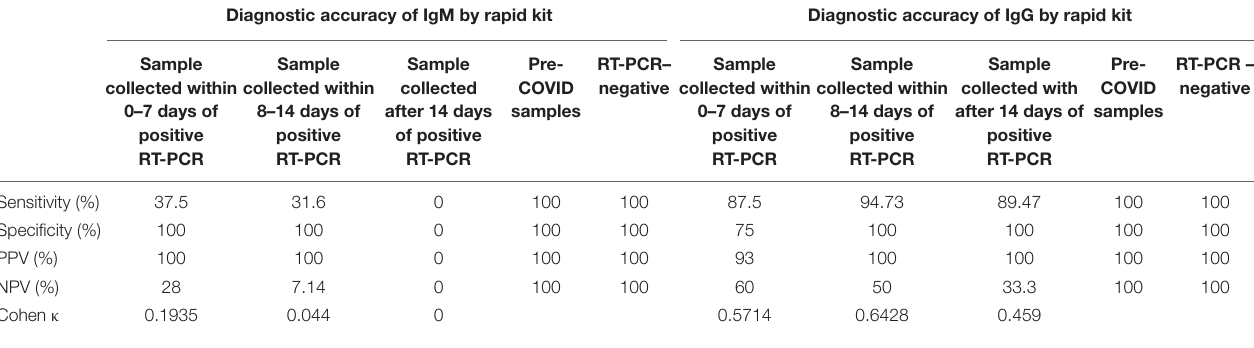
TABLE 5 | Accuracy indices of IgM and IgG antibody (against the RBD of the spike protein of SARS-CoV-2 virus) by rapid test for the diagnosis of COVID-19 (calculated by taking total antibody levels by ECL as standard methods. Diagnostic accuracy of IgM by rapid